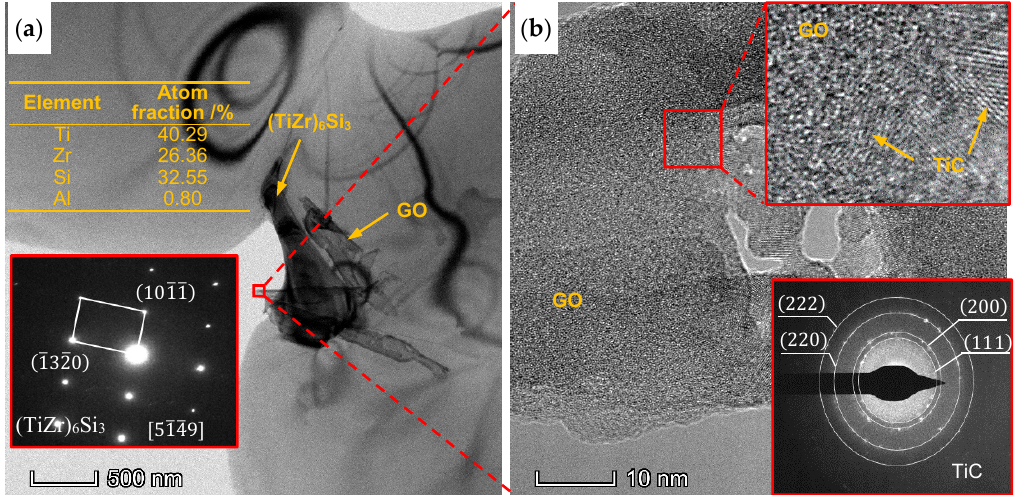
Figure 9. ( a ) TEM image of the composite with 0.3 wt% GO addition, the insert figure and table are the selected area electron diffraction (SED) pattern and EDS analysis result of precipitate; ( b ) HRTEM image of GO; insert figures are the enlarged view and SED pattern of GO.